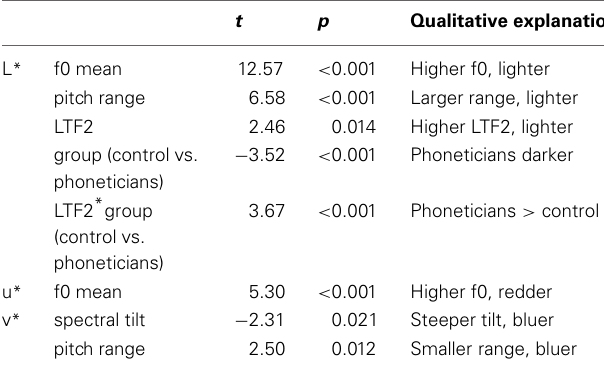
Table 4 | Results of linear mixed effects modeling testing acoustic influences on participants’ color associations.